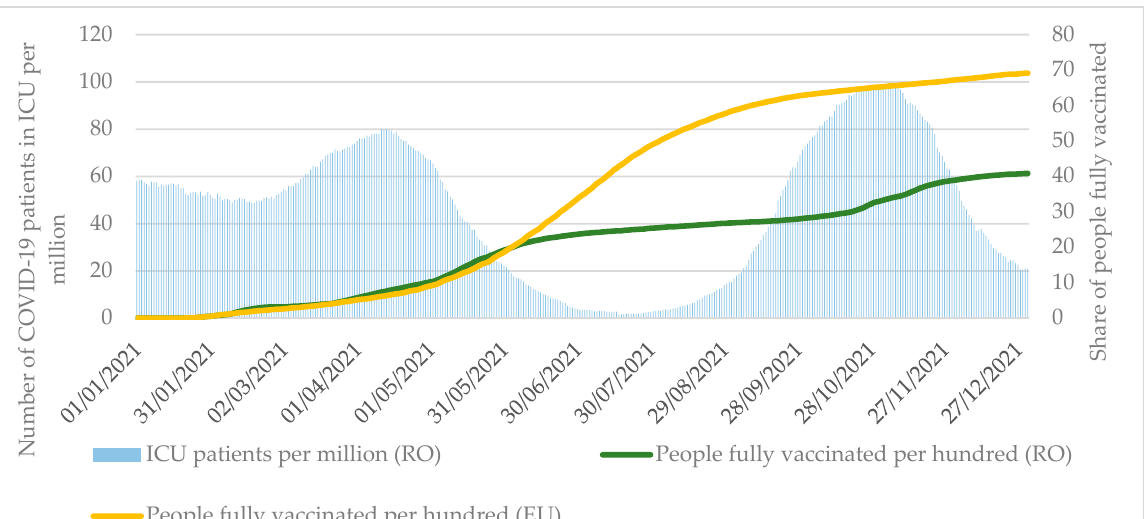
Figure 2. Number of COVID-19 patients in ICU per million and number of fully vaccinated people per hundred in Romania between 1 January and 31 December 2021. Source: University of Oxford [21].